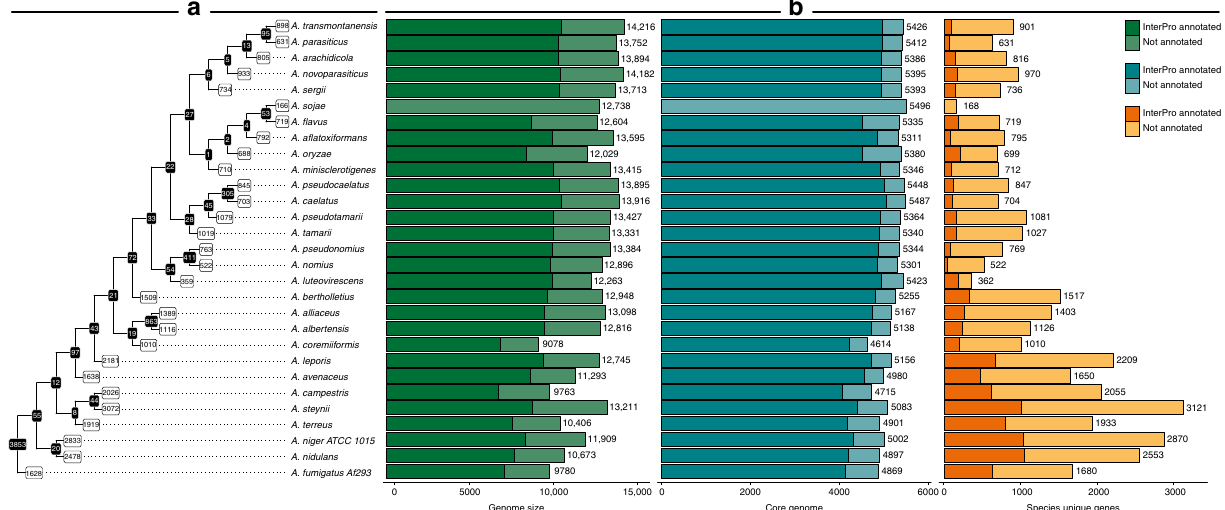
Fig. 2 Core-speci fi c, section-speci fi c, and clade-speci fi c and species-unique genes. a A dendrogram representing the phylogenetic relationship between the 29 Aspergilli. The black boxes in the nodes represent the homologous protein families shared among the species branching from that node. The white boxes at the tips represent the protein families unique to that individual species. b A barplot showing the number of total (green), core (turquoise), and species-speci fi c (orange) proteins for each species. The dark shading illustrates the number of proteins with a least one functional annotation based on InterPro 32